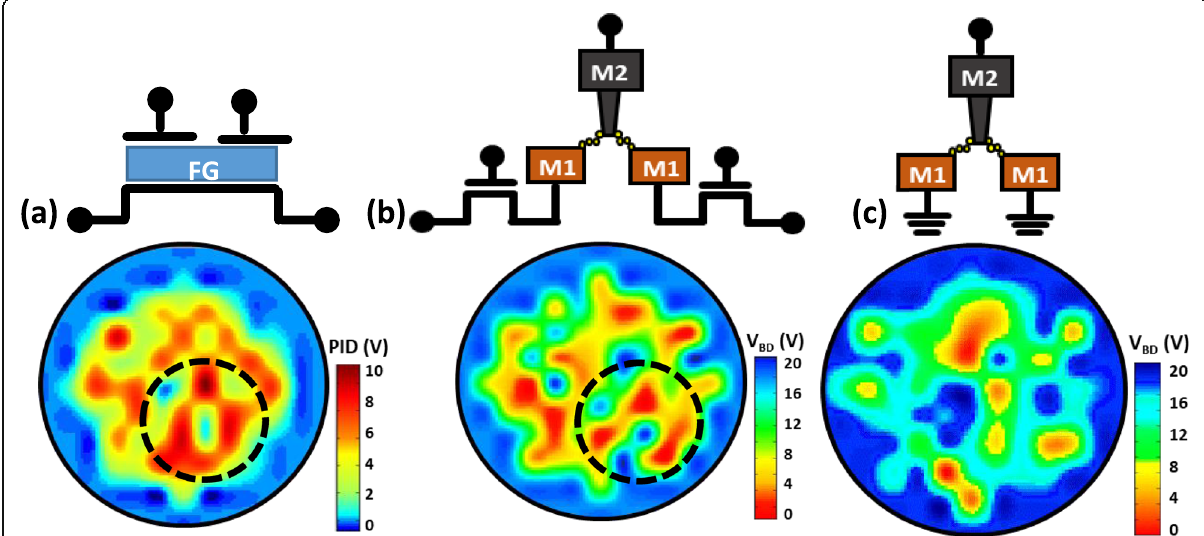
Fig. 5 Schematics and the wafer maps showing the distributions of ( a ) the PID voltage and VBD from ( b ) test pattern I and ( c ) II, showing the regional effect within the circled area from plasma-induced damage on the back-end dielectric layer that can be attributed to the regional plasma charging levels